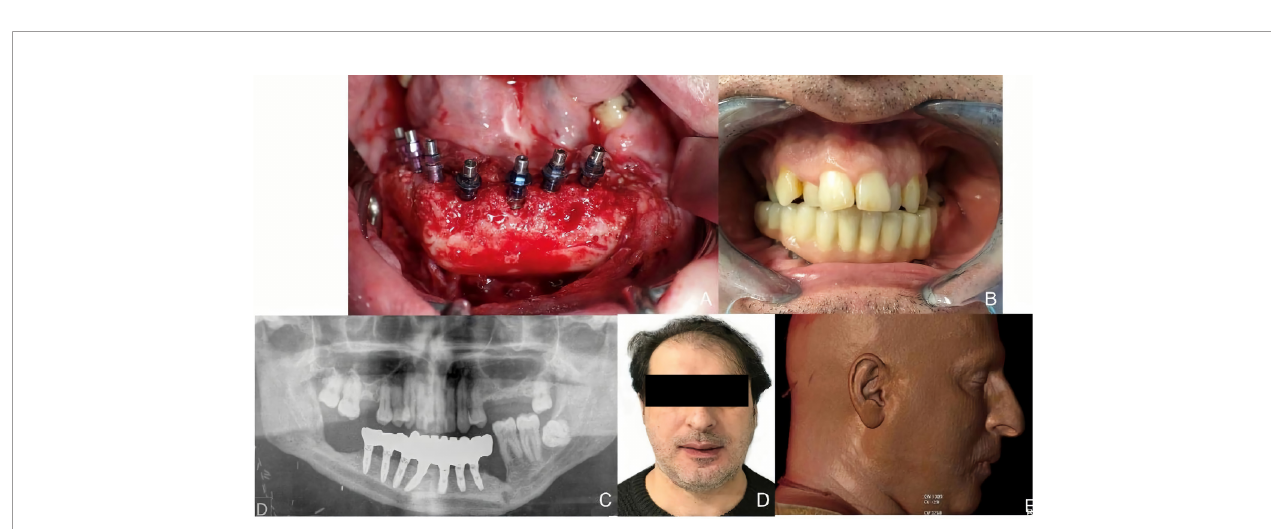
FIGURE 8 | (A) Placement of Ticare ® dental implants. (B) Final dental restoration. (C) Panoramic radiograph demonstrating the reconstruction of the previous height of the mandible with a correct osseointegration of the implants. (D) Aesthetic result with mandibular symmetry. (E) Morphing performed after implant rehabilitation, demonstrating a signi fi cant aesthetic improvement after 3D reconstruction with iliac crest